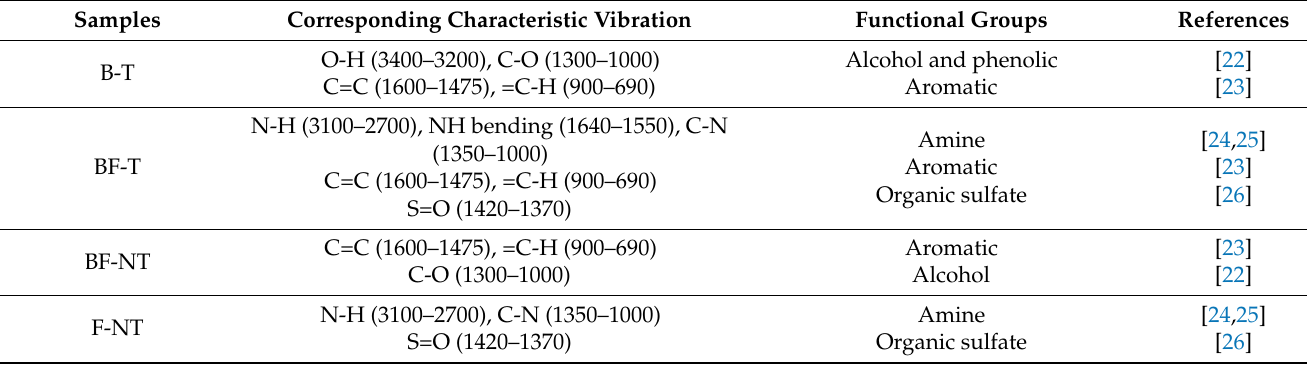
Figure 1. FTIR spectra of biochar tablets (B-T), biochar and fertilizer with (BF-T) and without tableting (BF-NT) as well as NPK fertilizer (F-NT). Table 2. FTIR wavenumber identification of biochar tablets (B-T), biochar and fertilizer with (BF-T) and without tableting (BF-NT) as well as NPK fertilizer